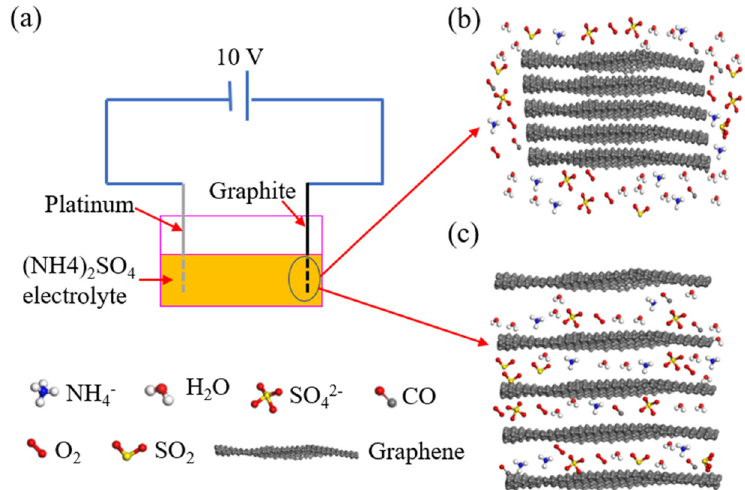
Figure 2: Electrochemical exfoliation of graphene in ( NH 4 ) 2 SO 4 aqueous solution. ( a ) The bias voltage is applied on the graphite electrodes in the ( NH 4 ) 2 SO 4 aqueous solution. ( b ) The attack of ions results in the expansion of graphite on the edge and boundary, which allows SO 42− anions, water molecules, and gas to penetrate into the adjacent layer in graphite. ( c ) The penetration of ions, water molecules, and gas in graphite overcomes van der Waals interaction between interlayers of graphite, which yields